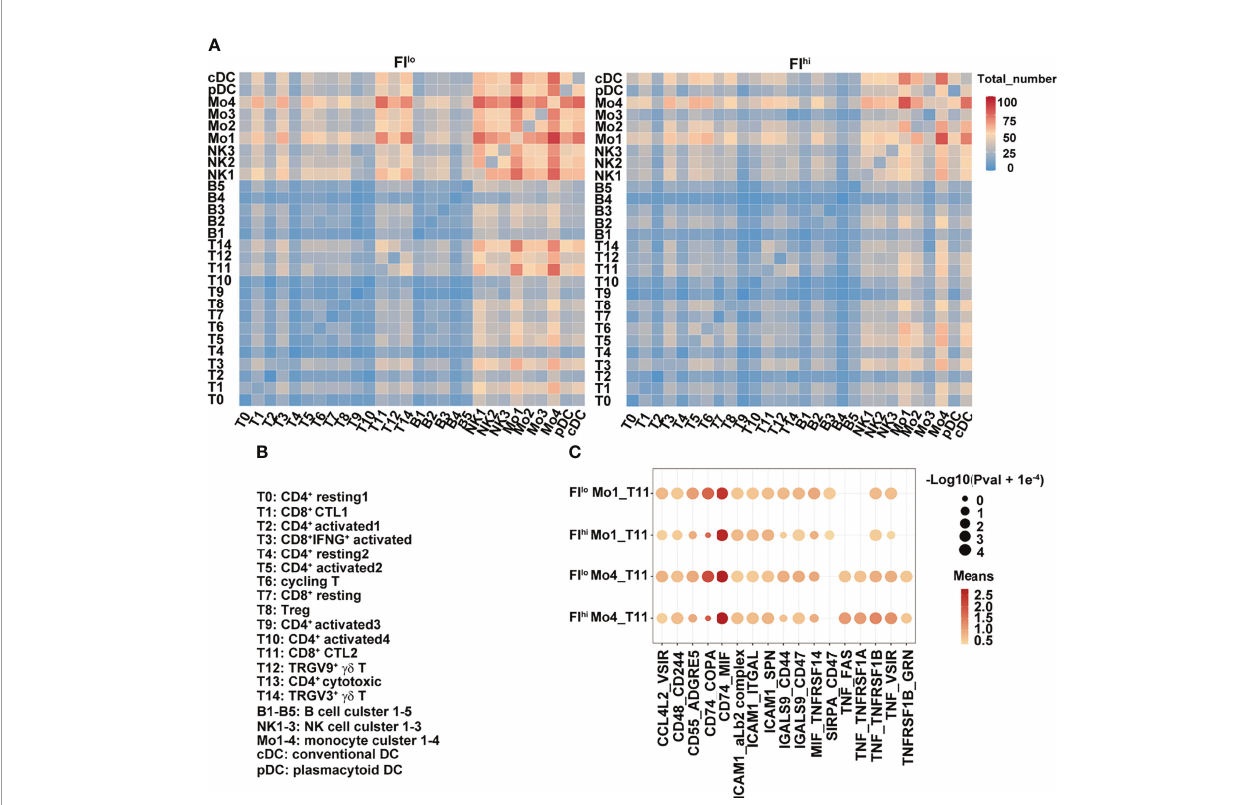
FIGURE 4 | Weakened interaction between T cells and other cell types in FI hi patients with severe COVID-19. (A) Heatmap shows the number of ligand and receptor pairs co-expressed among various cell types and cell clusters in the patients with severe COVID-19. The results derived from FI lo and FI hi patients were separately shown. (B) Lists of the names of the cell clusters. (C) Bubble plot shows mean expression of ligand and receptor pairs co-expressed between monocyte clusters (Mo1 and Mo4) and CTL cluster T11. The results derived from FI lo and FI hi patients were separately